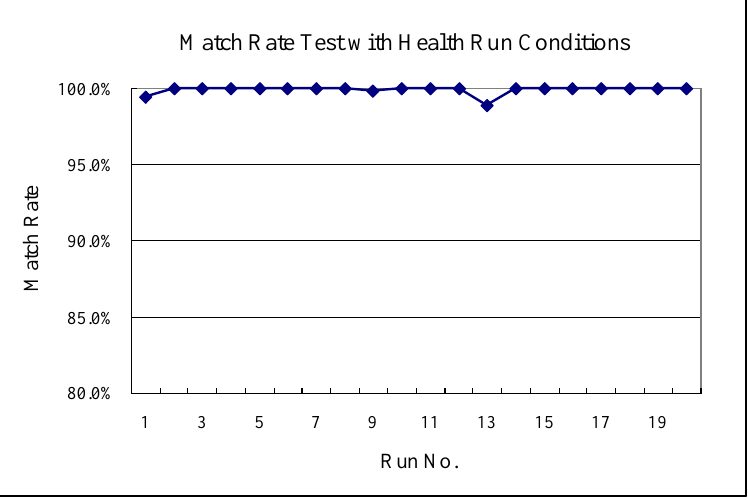
Figure 9. The match rate of the health process data compared to the sigma model. Match Rate Test with Health Run Conditions